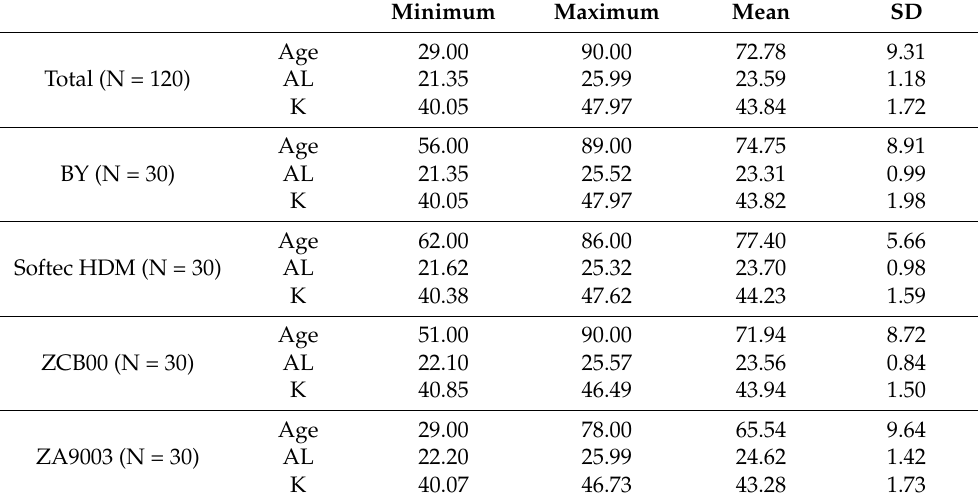
Table 1. Demographic data of the sample.